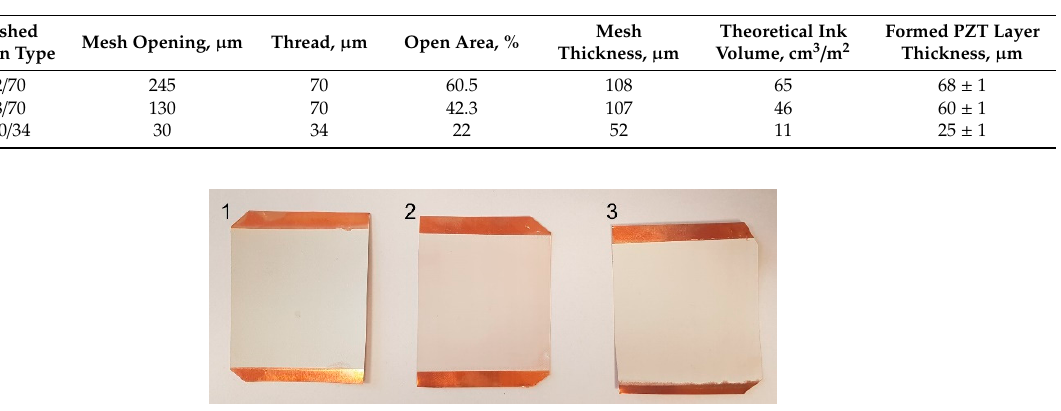
Figure 2. Photo of the polyester monofilament screen (a) and layer applicator (b). Table 1. Properties of polyester monofilament screens and lead zirconate titanate (PZT) composite layer thickness.